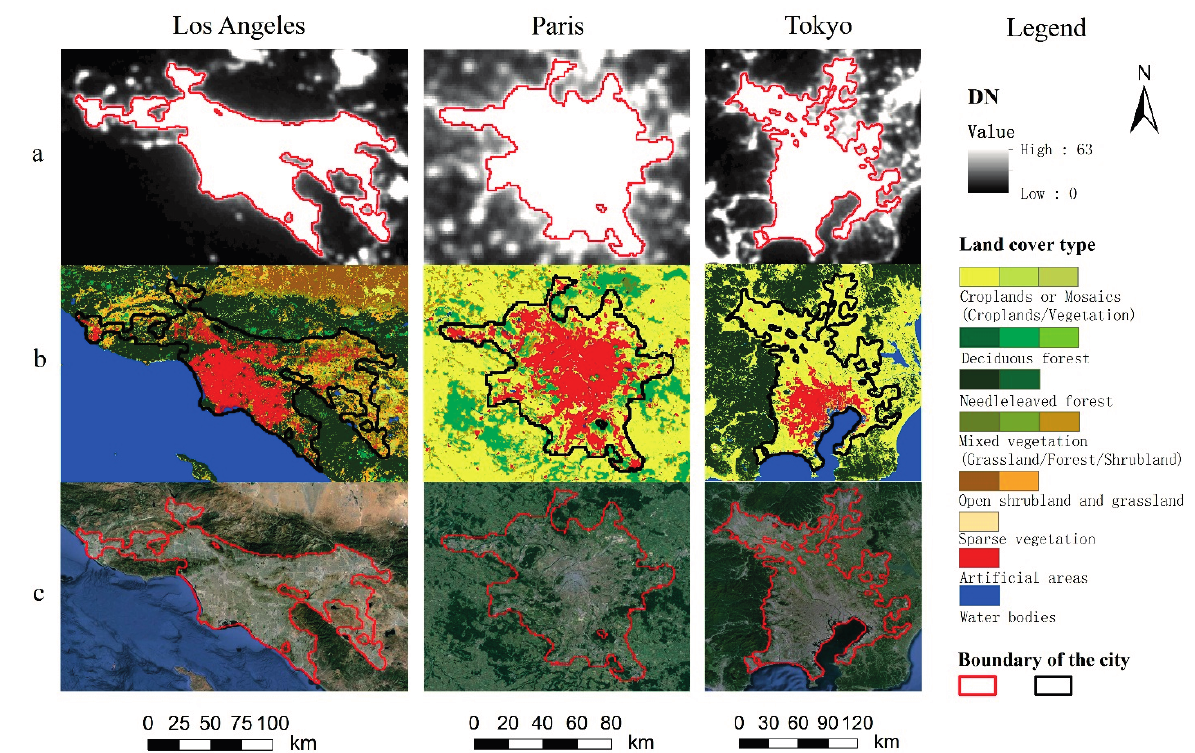
Figure 1. The boundary of three metropolises: ( a ) DMPS/OLS NTL in 2012; ( b ) GlobCover 2009 land cover map. The legends of the land cover types were merged for the display; ( c ) Image from Google Earth in